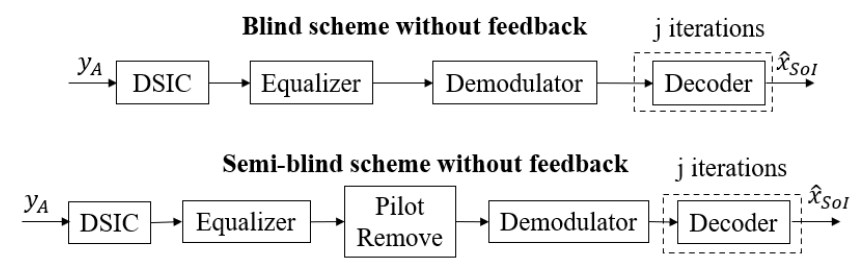
Figure 2. Conventional schemes without